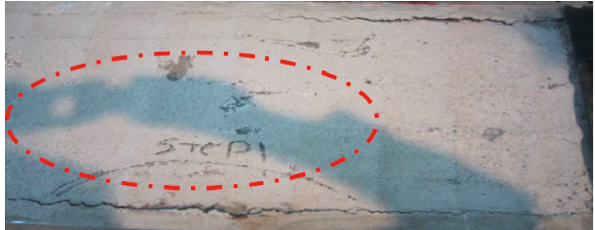
Figure 16: Longitudinal cracks between the cold-rolled galvanized sheets and the foamed concrete.